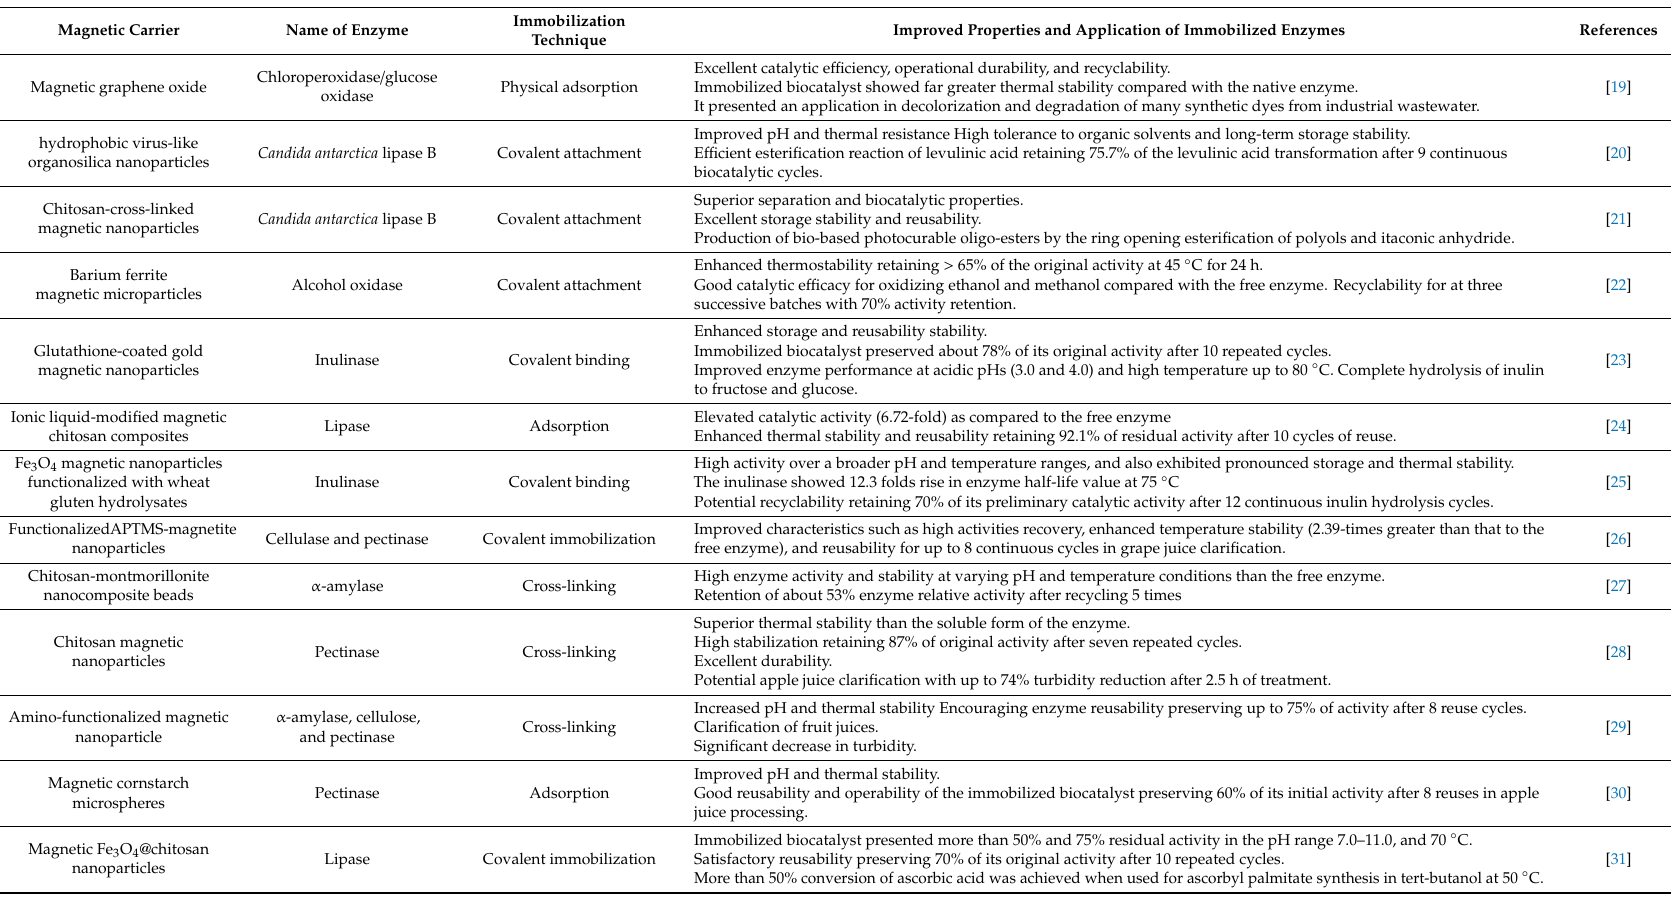
Table 1. Summary of magnetic nanomaterials as versatile carriers for enzymes immobilization, and their